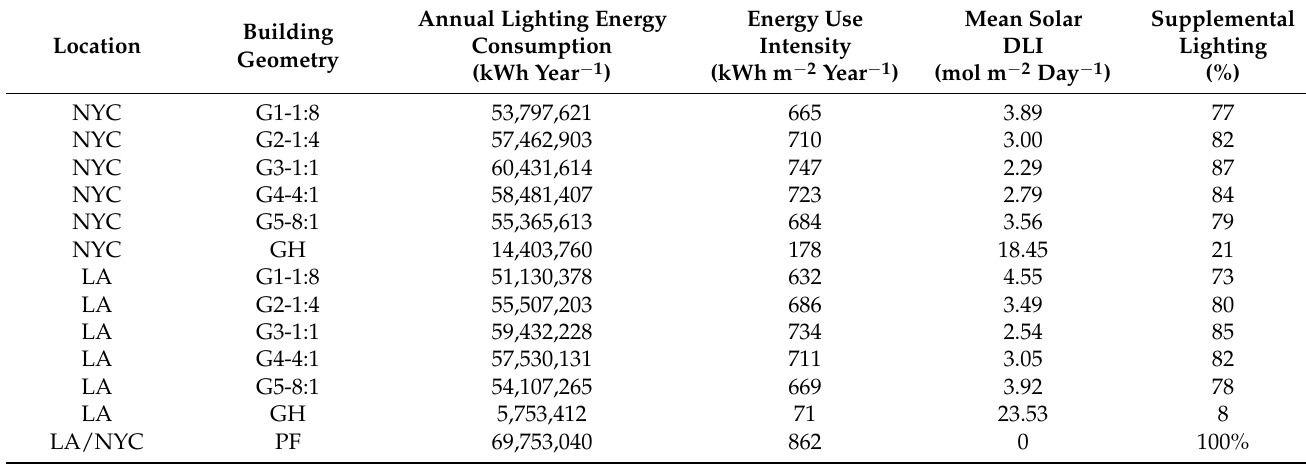
Table 2. Result summary for five 20-storey (20-acre) skyscraper farms and a 20-acre greenhouse in NYC and LA. PF: plant